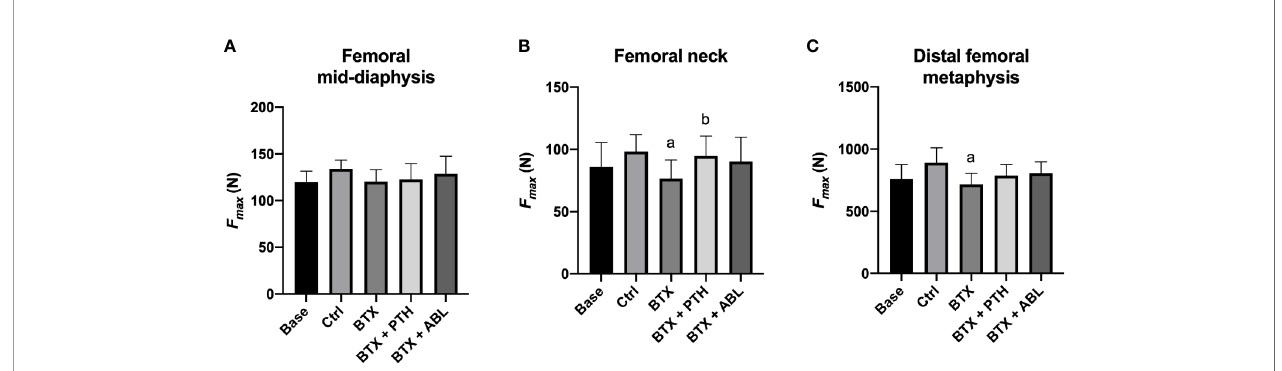
FIGURE 7 | Fracture strength ( F max ) of the femoral mid-diaphysis (A) , femoral neck (B) , and distal femoral metaphysis (C) of rats with the right hindlimb immobilized with BTX and treated with PTH or ABL. Data are presented as mean ± SD. a: p < 0.05 vs. Ctrl. b: p < 0.05